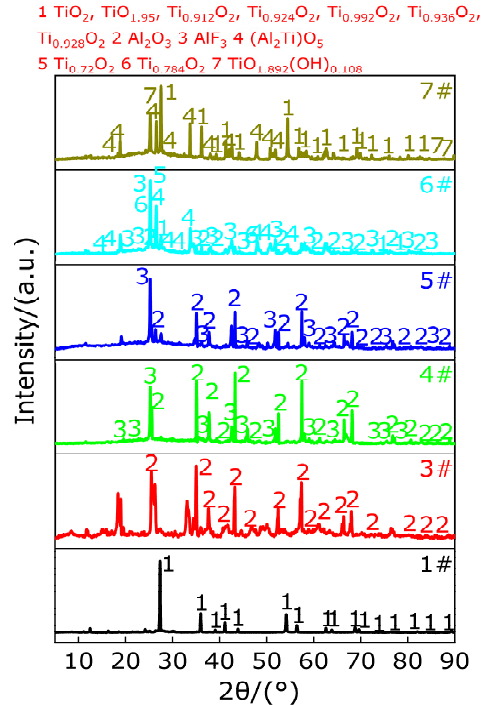
Figure 23. XRD patterns of oxygen bomb experiment residues of materials 1#, 3#, 4#, 5#, 6# and